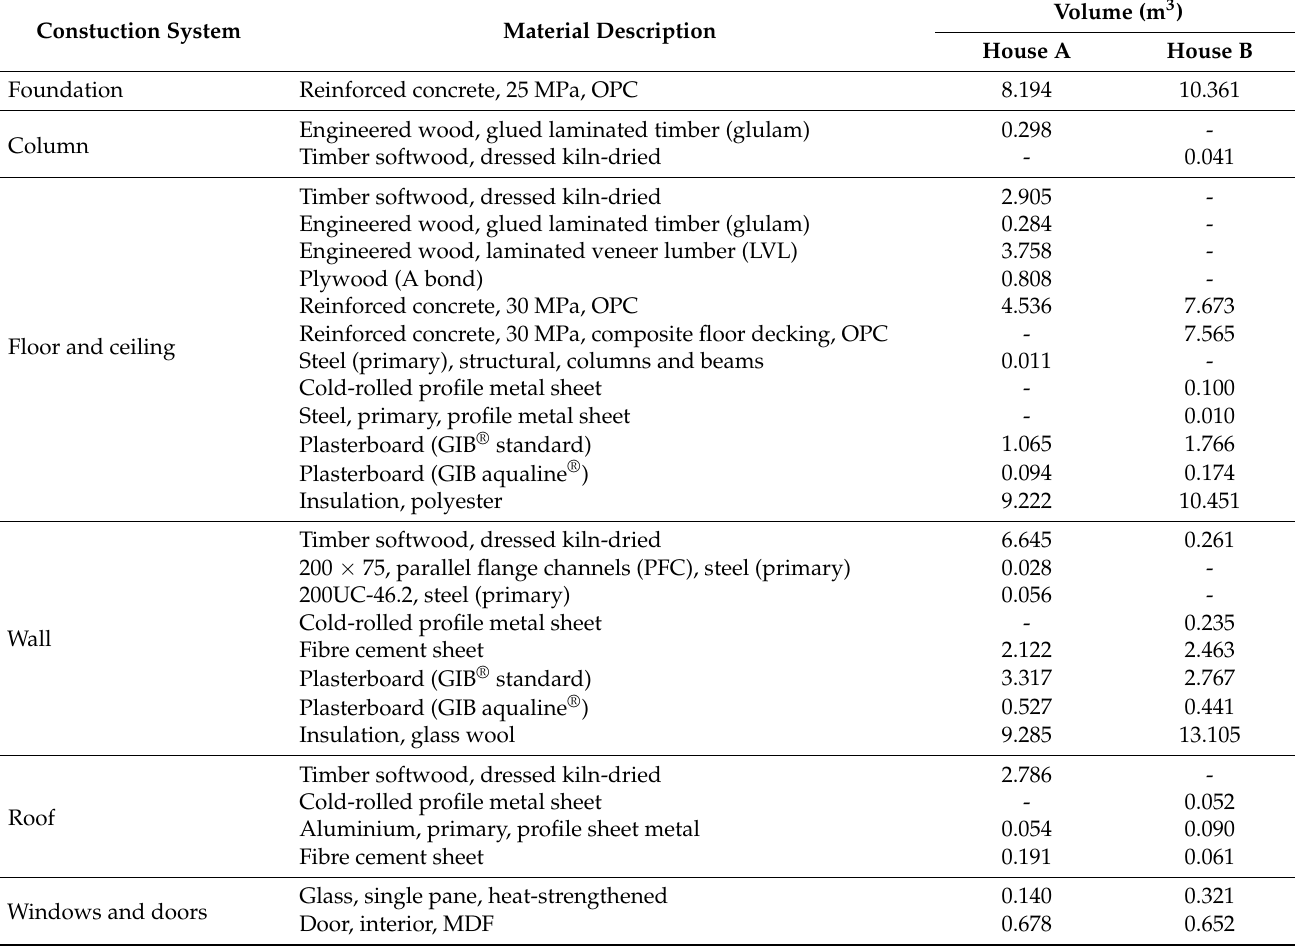
Table 2. Material take-off data of two investigated